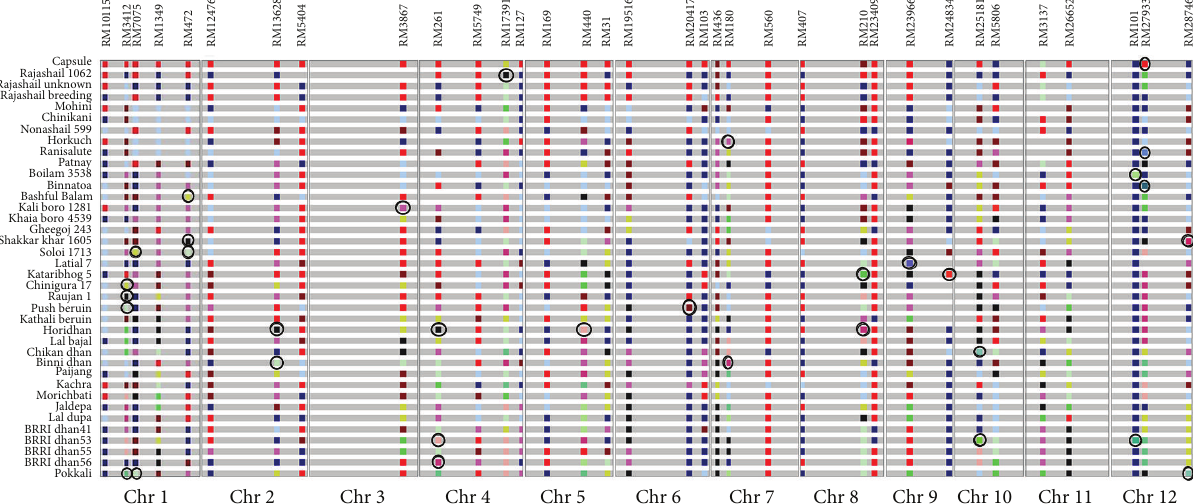
Figure 3: Identity map for all varieties created using GGT software [17] showing the unique identifiers among 12 chromosomes of rice. ( The unique identifiers are